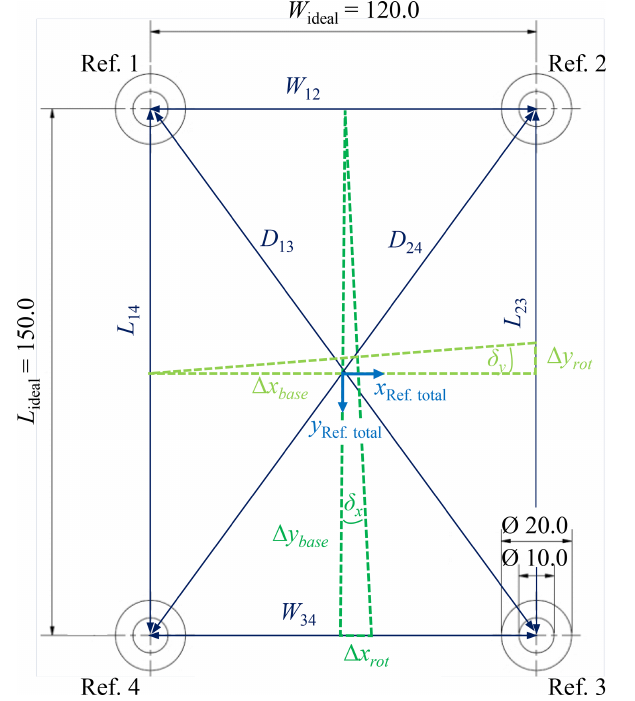
Figure 8. Designation of distances between the reference